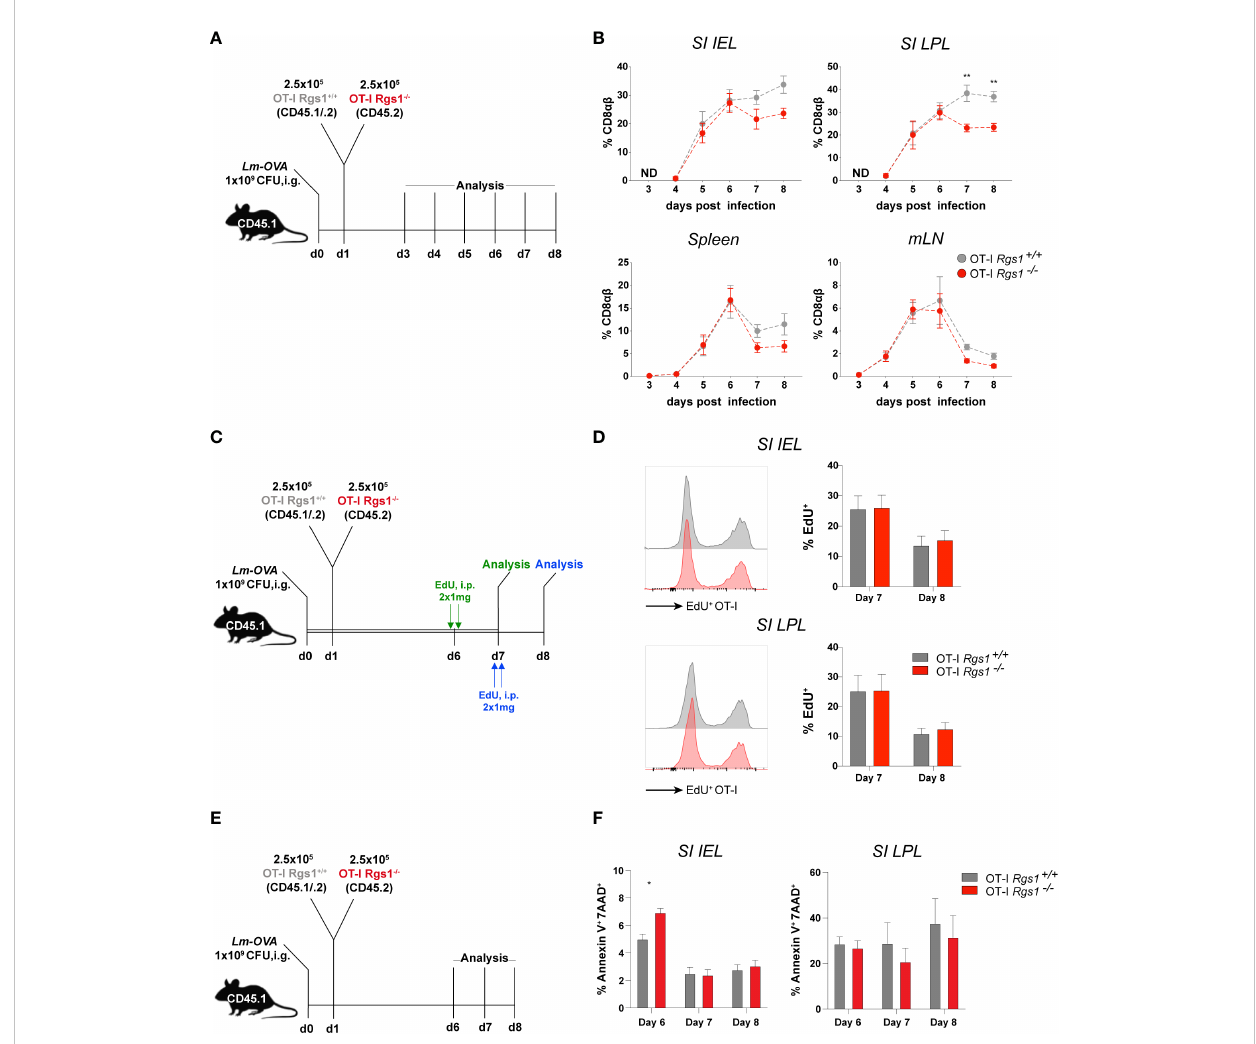
FIGURE 5 Antigen-speci fi c OT-I Rgs1 -/- T cells become underrepresented early after intestinal infection with Lm- OVA. (A) Experimental set-up to determine the relative frequency of co-transferred Rgs1 +/+ vs . Rgs1 - /- OT-I CD8 T cells. (B) Frequencies of co-transferred OT-I Rgs1 +/+ vs . OT-I Rgs1 -/- T cells in the small intestinal epithelium (SI IEL), lamina propria (SI LPL), the spleen, and mesenteric LN (mLN), on day 3, 4, 5, 6, 7 and 8 after oral infection with Lm-OVA . (n=4-10, mean ± SEM, 2-way-ANOVA with Sidak ’ s multiple comparisons test, **, p < 0.01). (ND, No transferred OT-I cells detected). (C) Experimental set-up for D . (D) Representative FACS histograms and respective frequencies of EdU positive proliferating Rgs1 +/+ OT-I (grey) and Rgs1 -/- OT-I (red) cells from the small intestinal epithelium and lamina propria (n=6 at day 7 and n=8 at day 8, pooled from 2 independent experiments, mean ± SEM, 2-way-ANOVA with Sidak ’ s multiple comparisons test, all p > 0.05 (not signi fi cant). (E) Experimental design to determine apoptosis rates of transferred OT-I cells. Apoptotic cells were detected by annexin V and 7-AAD staining in Lm-OVA infected (i.g.) recipient mice on days 6, 7 and 8 p.i. Mice were treated i.p. with 50 m g anti-ARTC2 nanobodies 20 min before sacri fi ce of the mice to prevent extracellular ATP/NAD + - induced, P2XR7/ARTC2-mediated apoptosis during isolation (29). (F) Frequencies of Annexin-V + 7-AAD + Rgs1 +/+ OT-I (grey) and Rgs1 -/- OT-I (red) cells, representing late apoptotic from cells, from the small intestinal epithelium and lamina propria (n=4 at day 6, n=5 at day 7 and n=6 at day 8, pooled from 2 independent experiments, mean ± SEM, 2-way-ANOVA with Sidak ’ s multiple comparisons test); *, p <